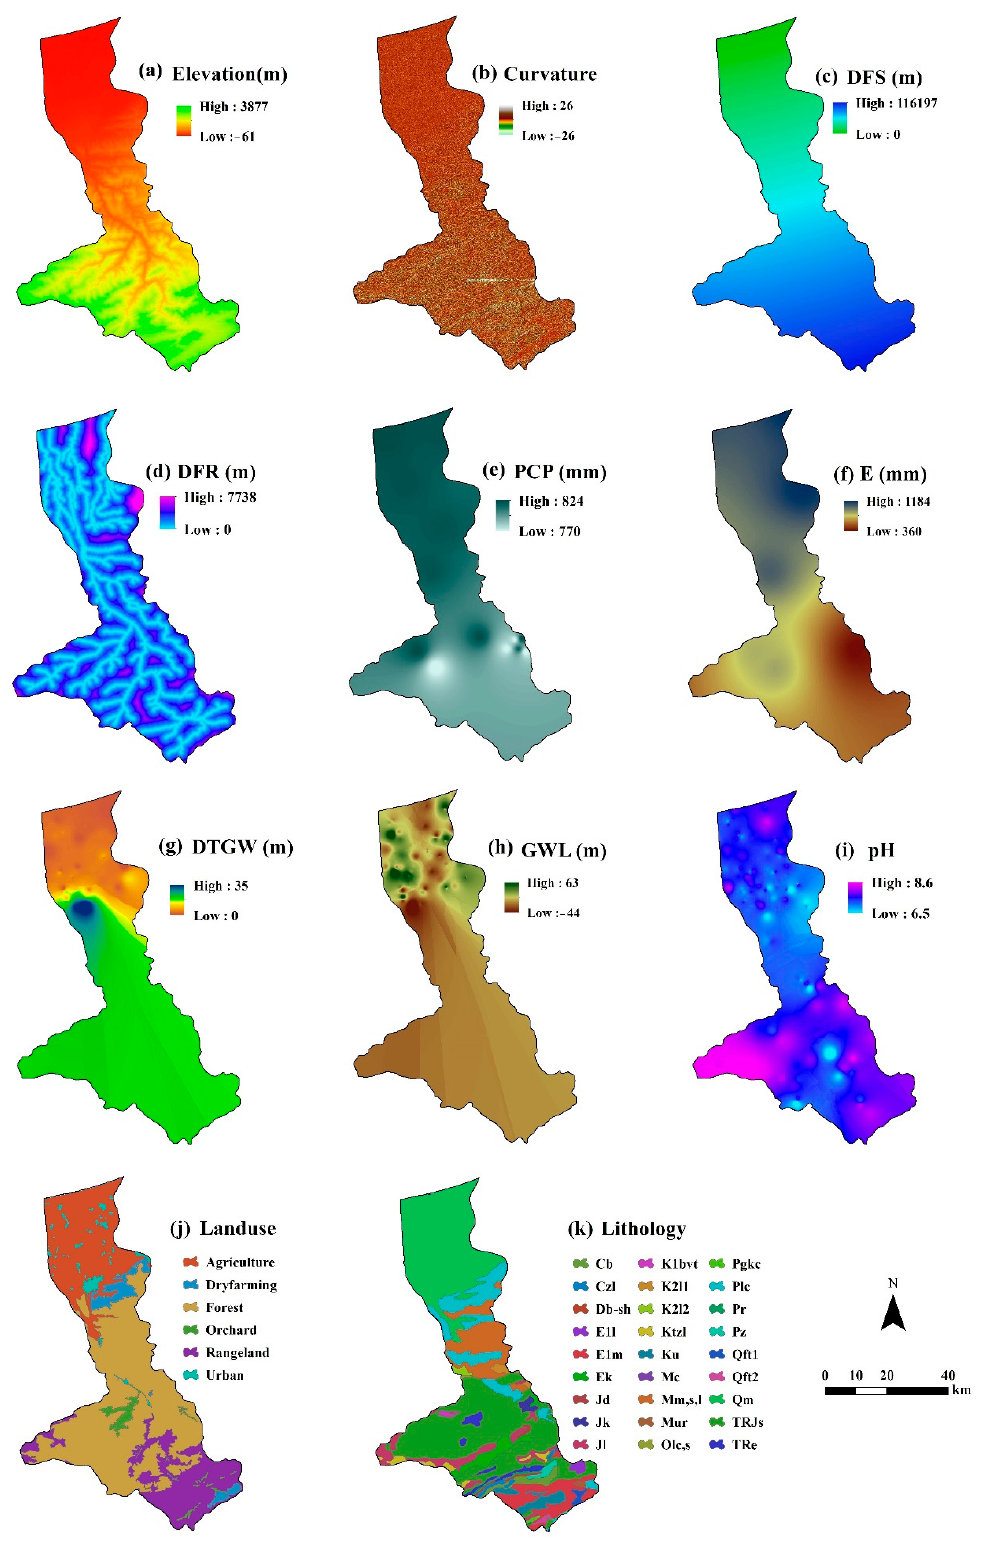
Figure 2. Environmental factors used for hardness susceptibility modeling: ( a ) elevation, ( b ) curvature, ( c ) distance from sea (DFS), ( d ) distance from river (DFR), ( e ) precipitation (PCP), ( f ) evaporation ( E ), ( g ) depth to groundwater (DTGW), ( h ) groundwater level (GWL), ( i ) pH, ( j ) landuse, and ( k ) lithology.